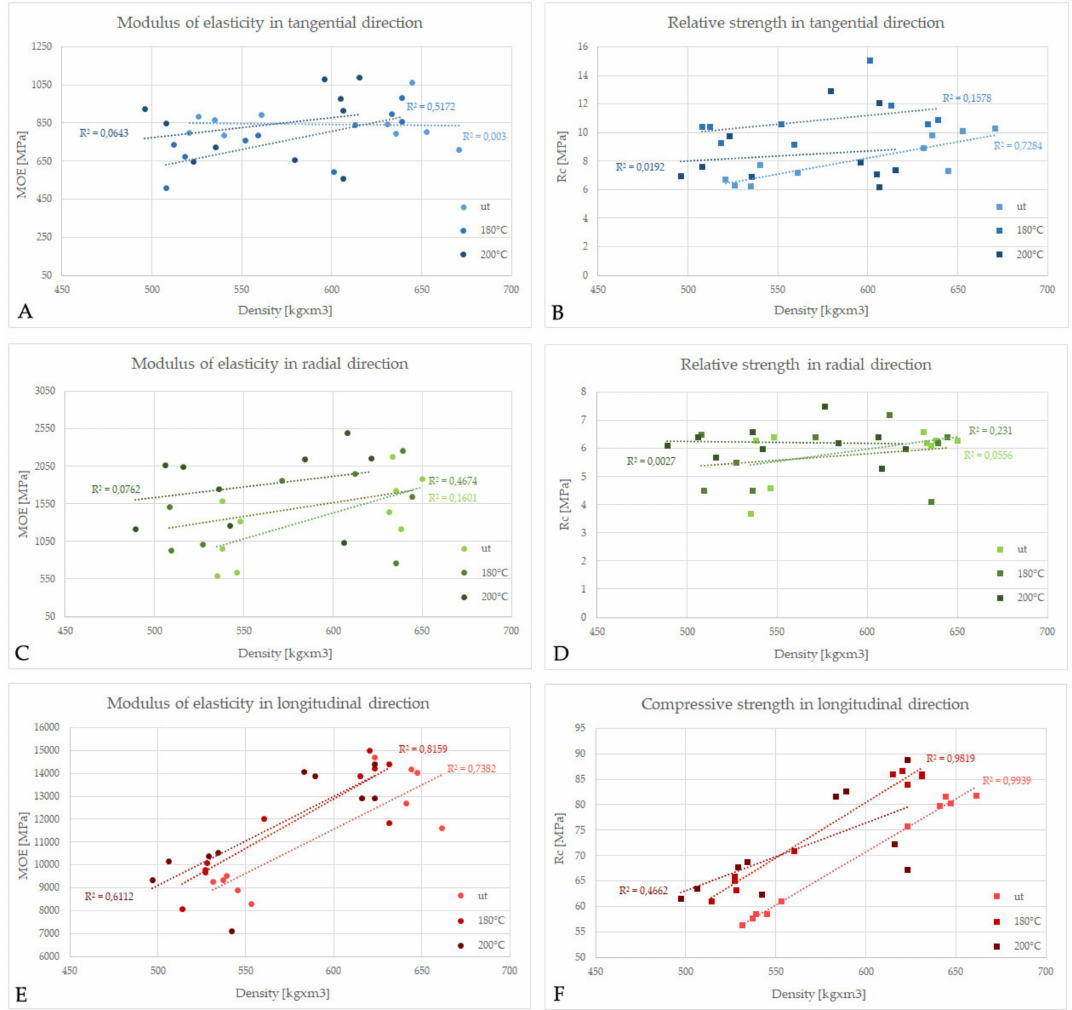
Figure 3. Modulus of elasticity (MOE) and relative / compressive strength (R c ) for a di ff erent density of unmodified and heat-treated ash measured at 3% MC in the tangential ( A , B ), radial ( C , D ), and longitudinal direction ( E , F